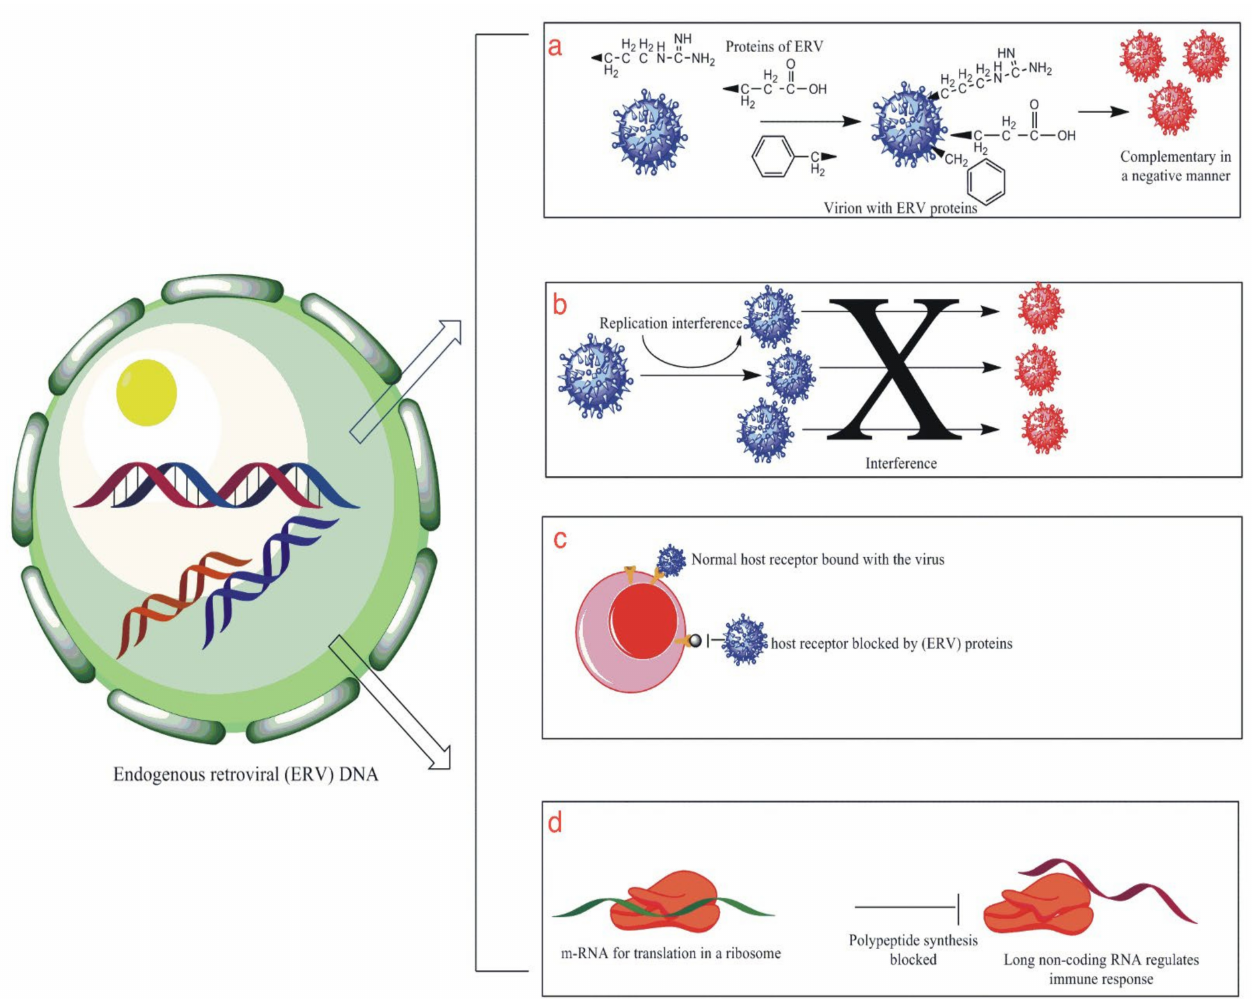
Figure 2. This illustrates some of the functions that HERV genome plays in protecting the human body against external viral infection. ( a ) shows the production of viral proteins by the HERV genome that are complimentary to the external virus in a negative way, thus affecting their success. ( b ) is an illustration showing the interference produced by HERV proteins that result in inhibiting or blocking the viral replication cycle. ( c ) is an illustration showing the phenomenon of receptor interference that involved the blockage of the site of entry for the foreign virus by HERV proteins, thus resulting in the prevention of viral infection of the cell. ( d ) is an illustration that shows the production of long non-coding RNA sequences that help in the modulation of the host antiviral immune